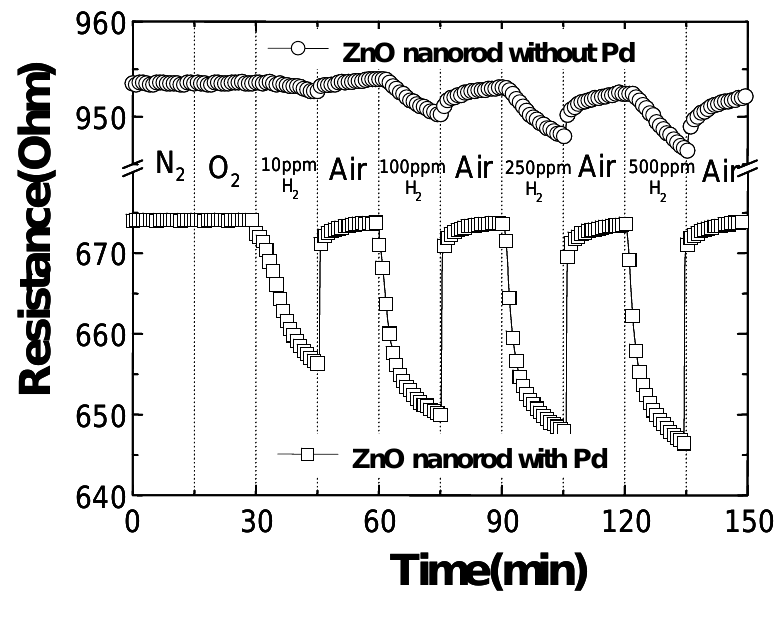
Figure 11. Relative response of Pd-coated nanorods as a function of H